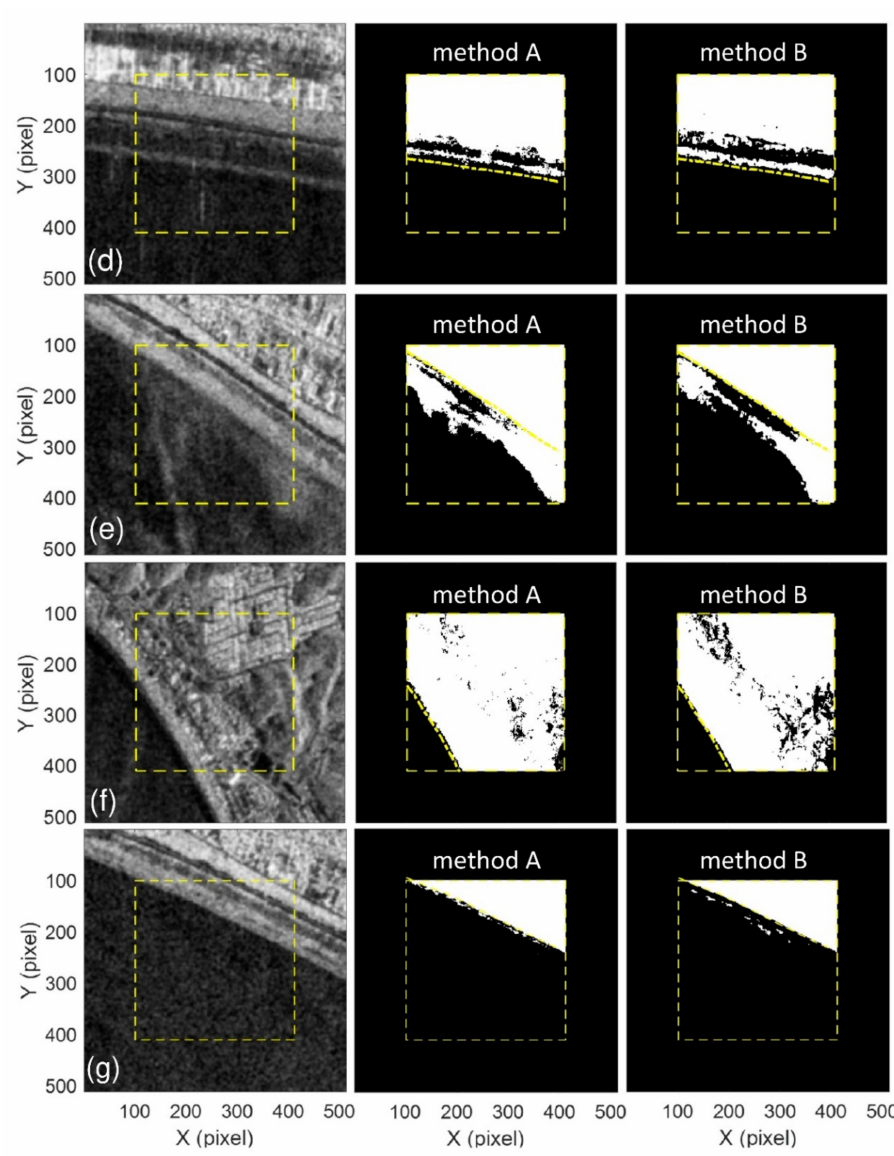
Figure 12. Examples of the classification results produced by the proposed NN model. The definitions of these panels are the same as those in Figure 9, but these panels are for different images, ( d – f ), which yielded relatively low-accuracy land–sea classification, as indicated in Figure 11. The image ( g ) is extracted from the same site as ( e ), but at a different observation